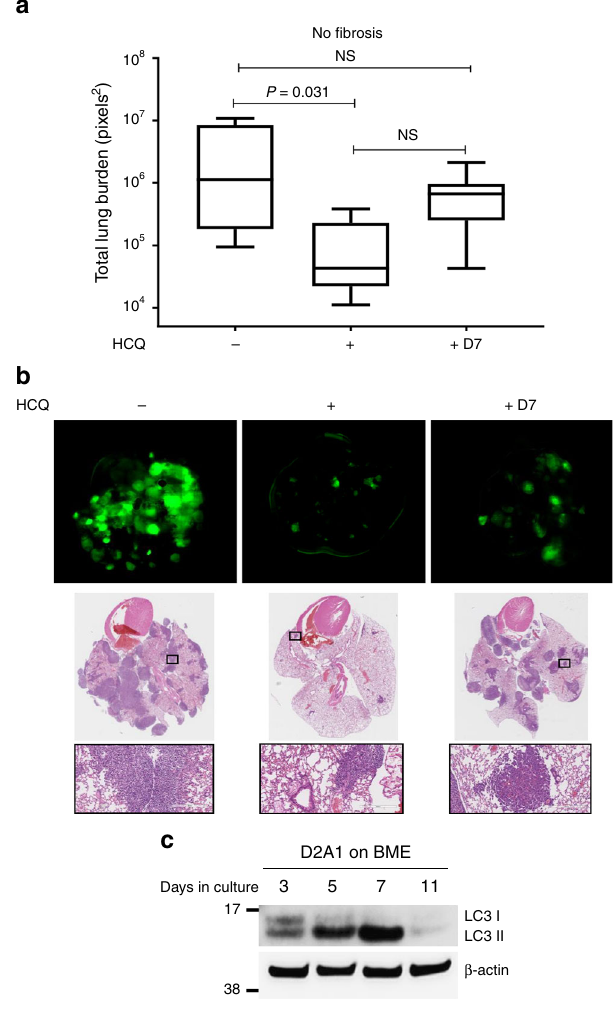
Fig. 5 Inhibition of autophagy reduces metastatic outbreak of dormant cells. a Total lung surface burden of CD1 nu/nu mice receiving Ad-empty (No fi brosis) or Ad-TGF- β 223/225 (Fibrosis) and tail vein injections of 1 × 10 6 D2A1-GFP cells. Mice received either vehicle ( − ), 50 mg/kg body weight of Hydroxychloroquine (HCQ) 5 days a week for 3 weeks ( + ) or vehicle daily for 7 days followed by 50 mg/kg body weight of HCQ 5 days a week for additional 2 weeks ( + D7) (mean ± s.e.m, n = 8 – 9 mice per group. Comparisons by Kruskal – Wallis, Dunn ’ s post test). b Representative images of metastatic lesions in the lung from a , upper panels, D2A1 cells expressing GFP; middle panels, H&E staining of cross sections of lungs; bottom panels, higher magni fi cation of H&E stained metastatic lesions.